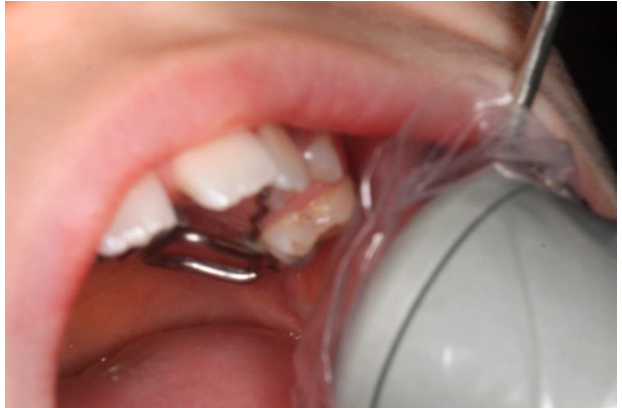
Figure 1. Low-level laser therapy (LLLT) administration. The optical fiber tip was moved from vestibular toward the palatal side of the upper first molar for 10 s (each